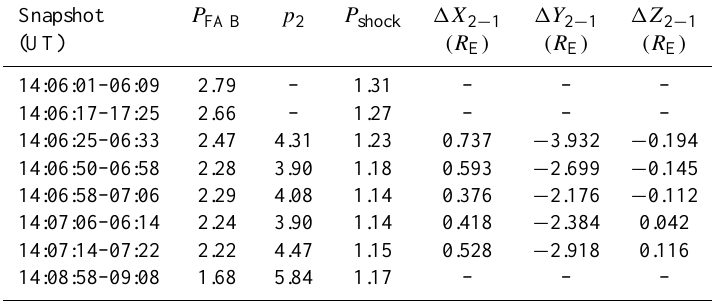
Table 1. Beam speeds and bow shock connection for a paraboloid shock model. Snapshot